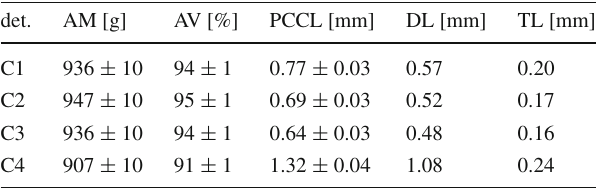
Fig. 4 Ionization spectrum of the C1 detector showing the 59.6keV γ - raylinefrom 241 Amdecaysandtherelatedcontinuumatlowerenergies. One MC simulated spectrum assuming a fully dead PCCL, and one dis- tinguishing between a partially dead and a partially sensitive transition layer (TL) are shown. Both are normalized to the measured line count rate, while the background is approximated with a flat component. The MCincludingtheTLmatchestheexperimentaldatabetter.Afullagree- ment depends on a correct inclusion of all background contributions, especially of the external natural radiation and of cosmogenic interac- tions inside the used shield Table 1 Active masses (AM), active volumes (AV) and thicknesses of the partialcharge collection, dead and transitionlayers (PCCL, DL, TL) of C1–C4